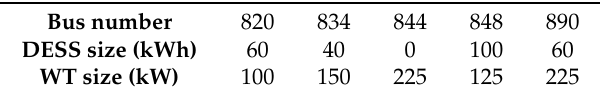
Table 2. System optimization results without controllable load.